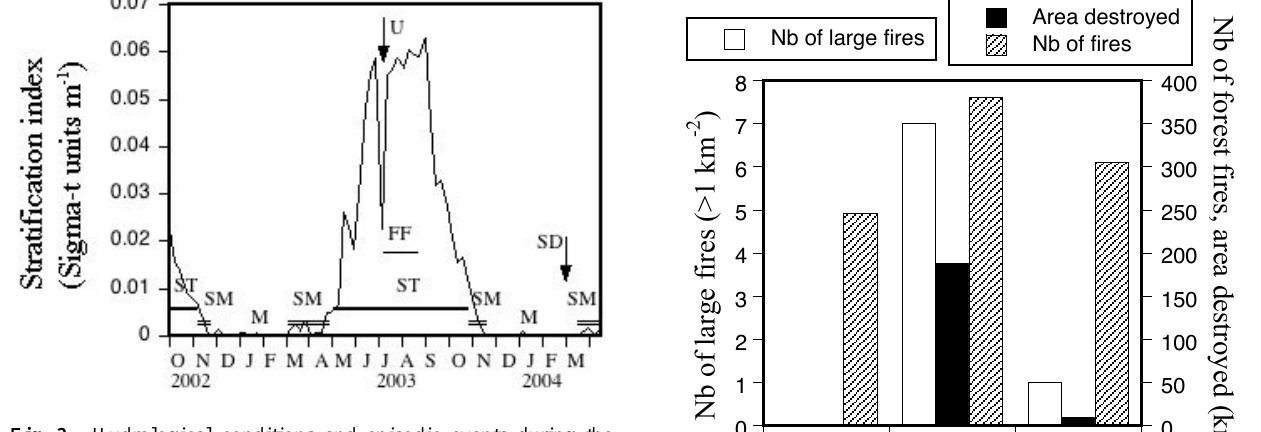
Fig. 3. Hydrological conditions and episodic events during the study period. Stratification index was calculated at the average den- sity difference m − 1 of the 0–75m layer (Bustillos-Gyzm´an et al., 1995). ST, summer stratification period (single line); M, mixed period; SM, semi-mixed conditions (double line), spring and fall- winter conditions; SD, Sahara dust deposition event, FF, forest fire period; U, upwelling event.